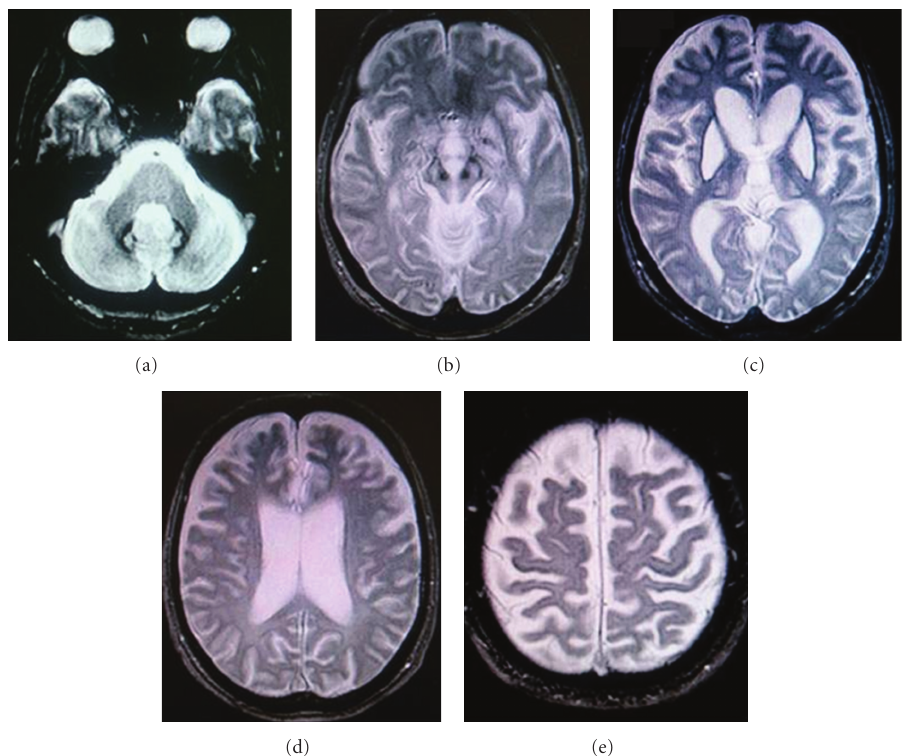
Figure 4: T2 ∗ -weighted images (TR 400 msec/ TE 25msec) obtained with a gradient echo sequence in the same patient at 42 years old. (a) A cross-section at the pontine level. The signal loss with central hyperintense lesions in the dentate nucleus is more obvious than that observed on T2WI. (b) An image of the midbrain demonstrates the hypointense change in the red nucleus. (c) Cystic degeneration of the basal ganglia with a rim of peripheral signal loss is obvious. In the thalamus, bilateral hyperintense abnormalities surrounded by slight hypointensity can be seen. (d) An image of a section of the central part of the lateral ventricles. (e) The iron deposition in the cerebral cortex is detected as signal